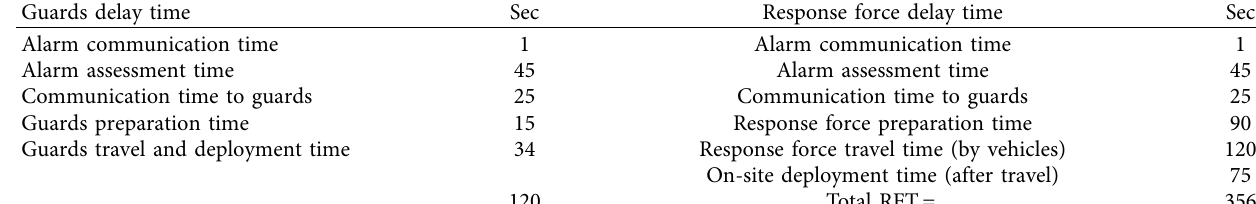
Table 1: Response force delay time RFT for scenario 1.1.